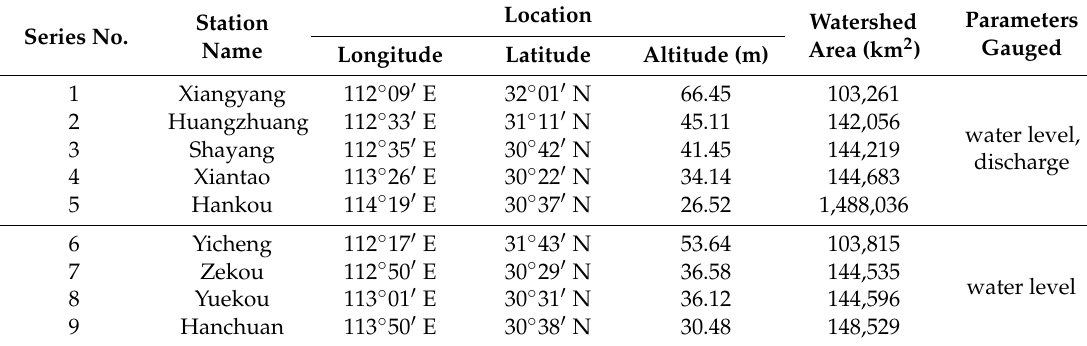
Table 1. The detailed information of gauging stations in the river system.